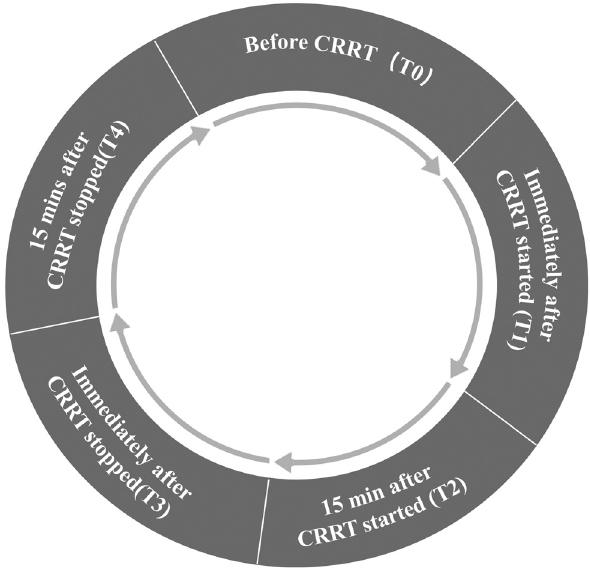
Figure 1: Study protocol and PICCO measurements at di ff erent time points. CRRT: continual renal replacement therapy; T0: before